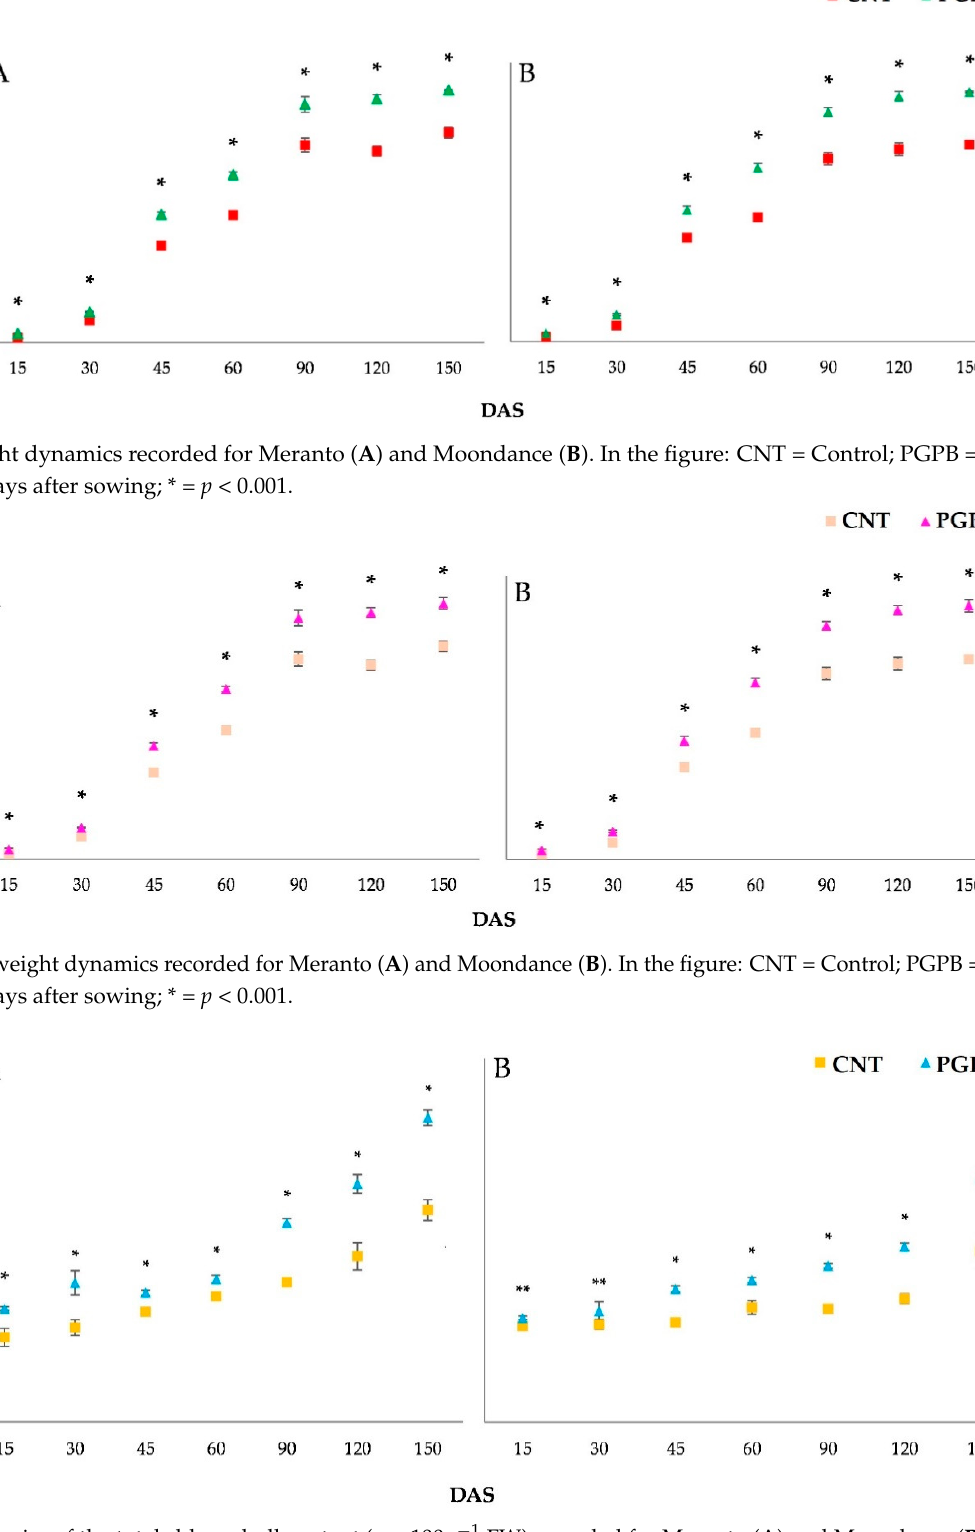
Figure 4. Dynamics of the total chlorophyll content (mg 100g − 1 FW) recorded for Meranto ( A ) and Moondance ( B ). In the figure: CNT = Control; PGPB = treated seed; DAS = days after sowing; * = p < 0.001; ** = p < 0.01.